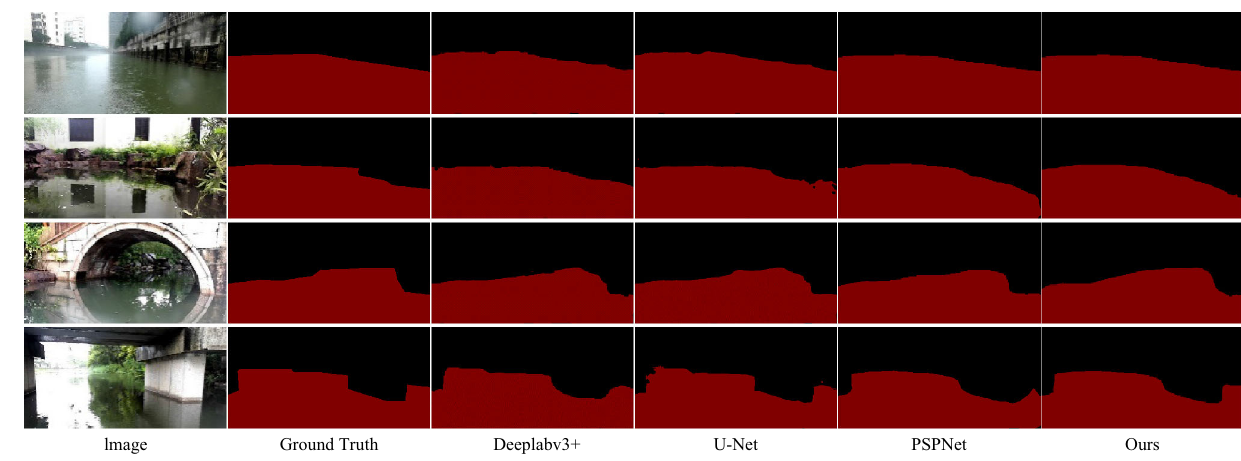
Fig. 11 The different network segmentation results